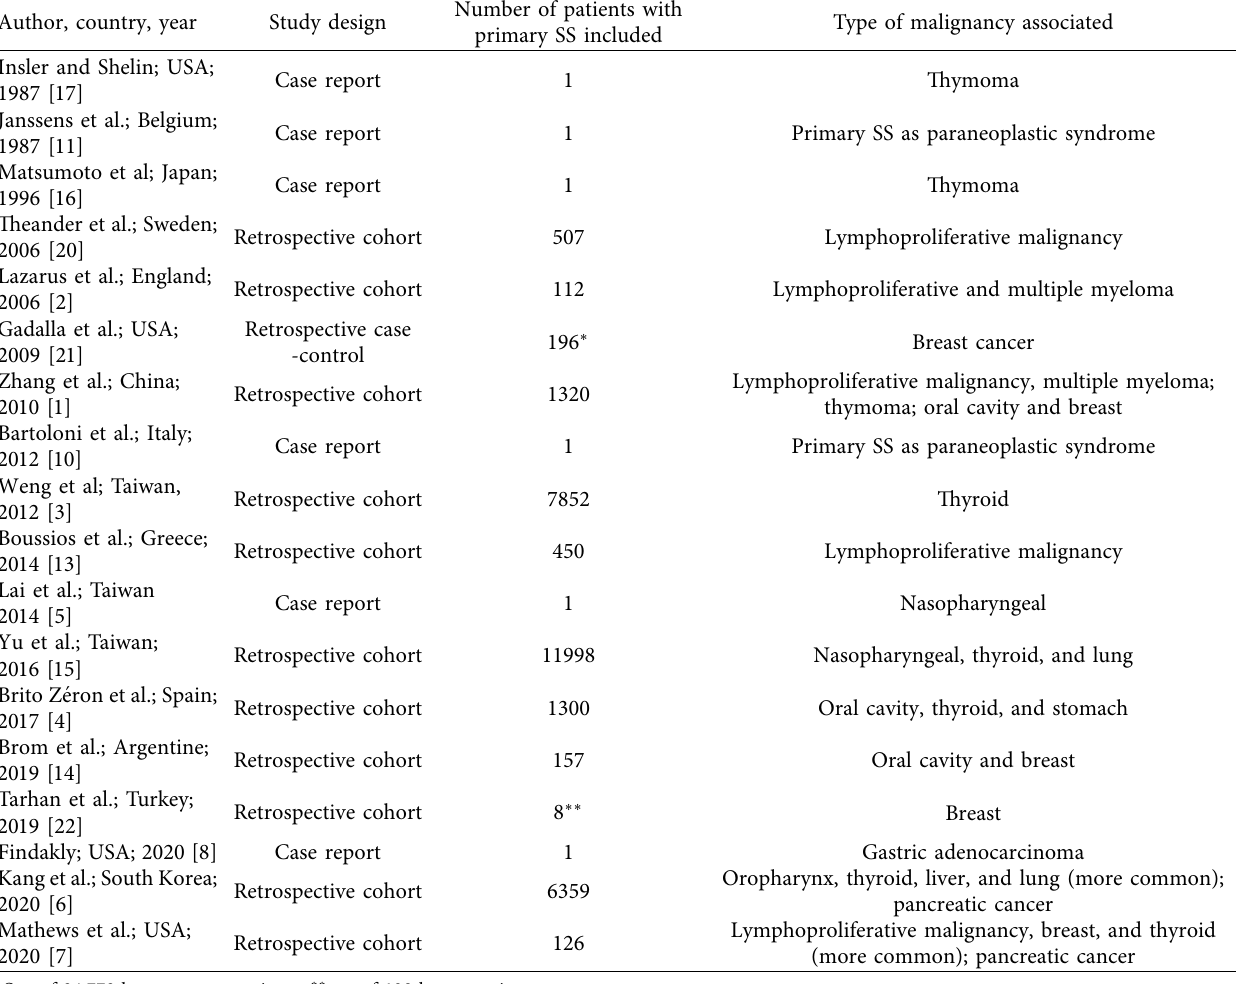
Table 1: Main original studies assessing solid cancer risk in primary